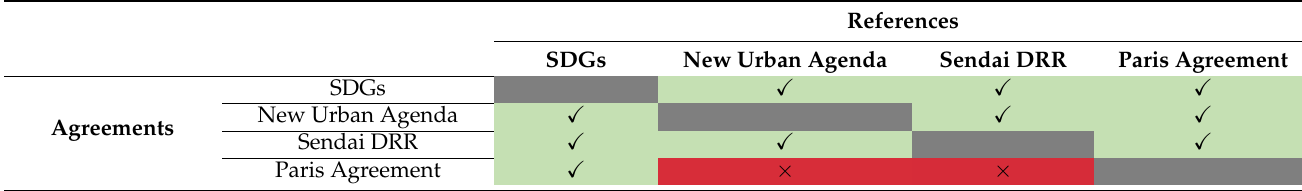
Table 6. Referenced links between the